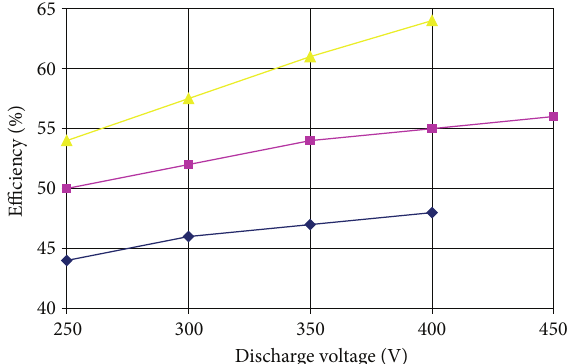
Figure 7: ATON A-3 anode efficiency versus discharge voltage for propellant anode mass flow rate of 2.3 mg/s: operation on Xe (yellow triangle 󳵳 ); operation on Kr (purble square ◼ ), optimized model; operation on Kr (blue diamond Q ), non optimized